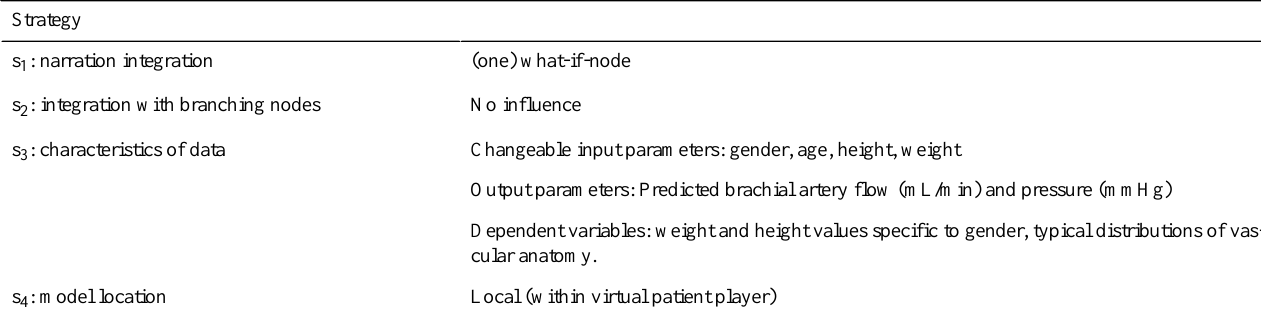
Table 4. VPH ARCH evaluation profile—selected integration strategies.